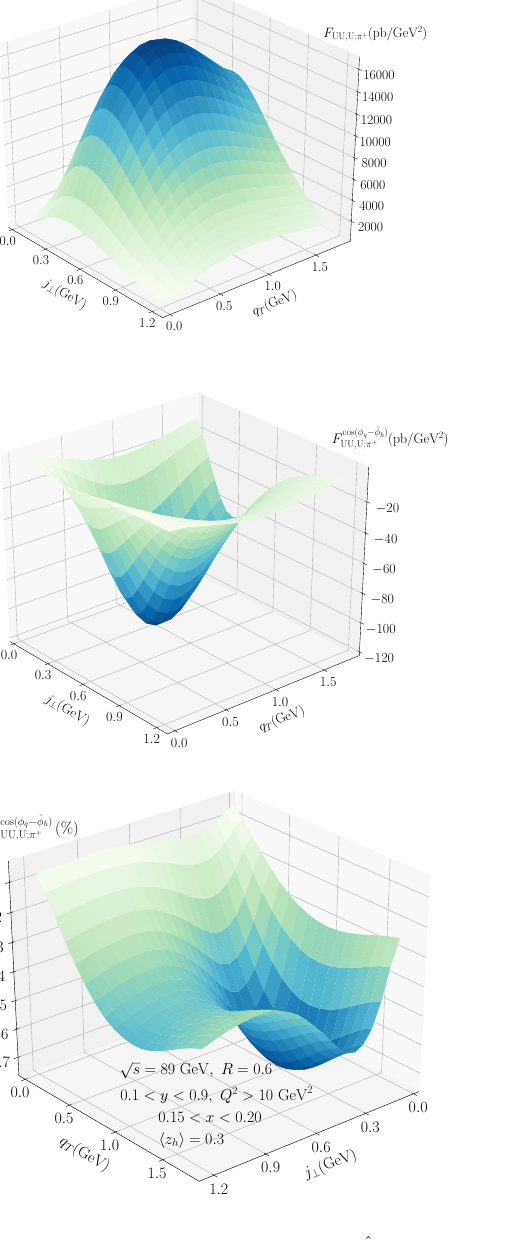
ˆ φ ˆ φ h ) h ) Figure 6 . F UU,U (first row), F cos( φ q − (second row) and A cos( φ q − (third row) as a function of UU,U UU,U jet imbalance q T and j ⊥ for unpolarized π + in jet production with electron in unpolarized ep collision √ with EIC kinematics, where we have applied s = 89 GeV, jet radius R = 0 . 6 , inelasticity y in range [0 . 1 , 0 . 9] , Q 2 > 10 GeV 2 , Bjorken- x in [0 . 15 , 0 . 20] and average momentum fraction h z h i = 0 . 3 . Left column: three dimensional plots of the structure functions and their ratio in q T and j ⊥ . Right column: contour plots of the structure functions and their